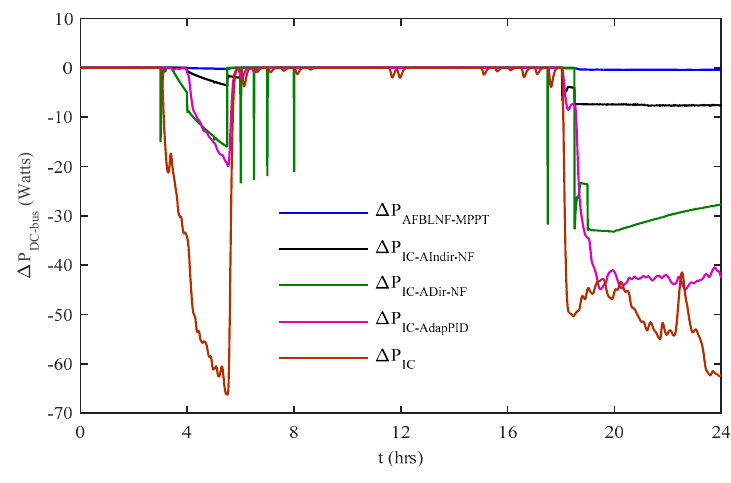
Figure 7. DC bus power deviation.